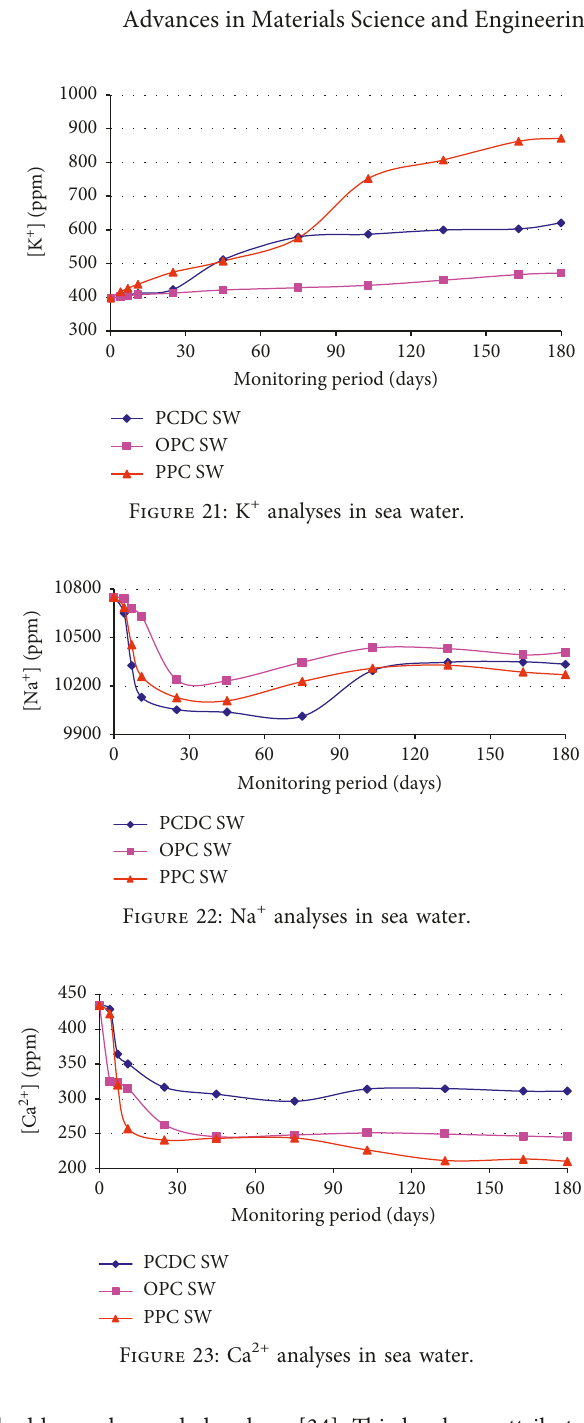
Figure 23: Ca 2+ analyses in sea